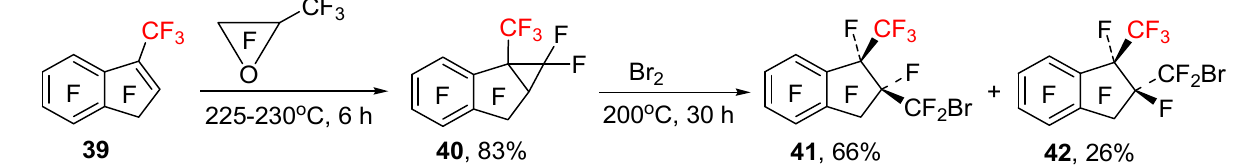
Scheme 24. Synthesis of 1-CF 3 -indanes 41 and 42 by bromination of compound 40 .